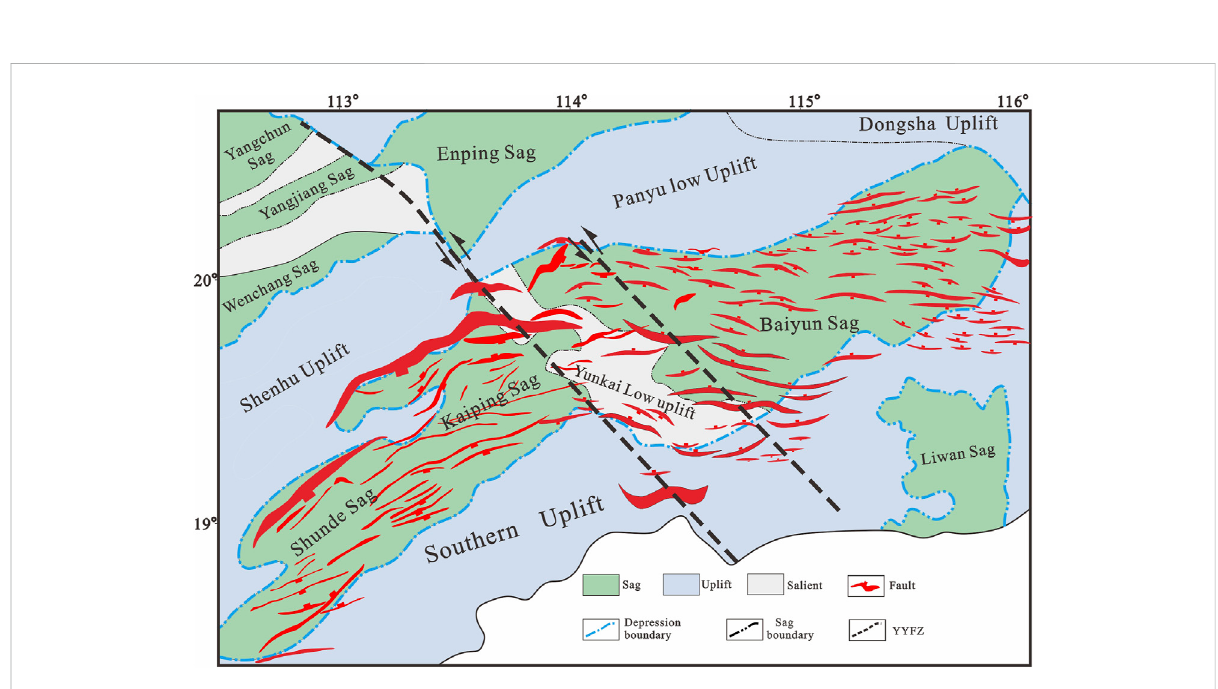
FIGURE 8 Structural units and fault pattern in the Zhu II Depression. The WNW- and E-W-trending secondary faults are assembled to produce an en echelon fault pattern in the T 80 interface. Figure location is shown in Figure 2 (revised from Wang et al., 2021).